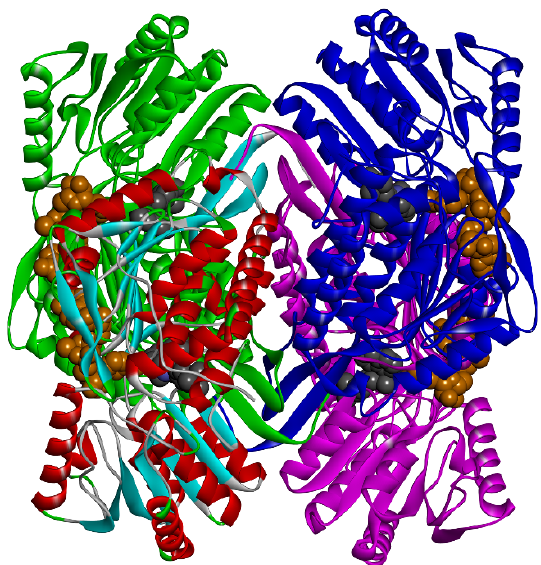
Figure 1. ALDH2 tetramer in complex with the cofactor NAD + and potential inhibitor butenafine. Proteins are represented with the solid ribbon model; chain A is colored by secondary structures (red for α -helix and cyan for β -sheet), while chains B, C, and D are in green, blue, and magenta, respectively. NAD + (orange) and inhibitor (dark grey) molecules are displayed using the space-filling model (CPK).